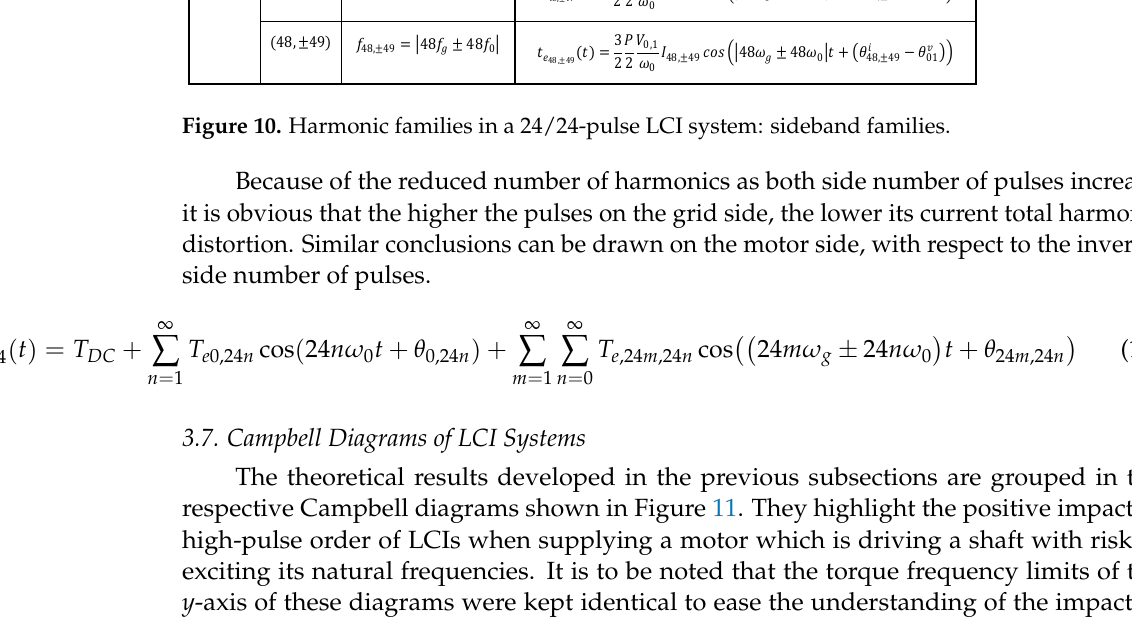
Figure 10. Harmonic families in a 24/24-pulse LCI system: sideband families.